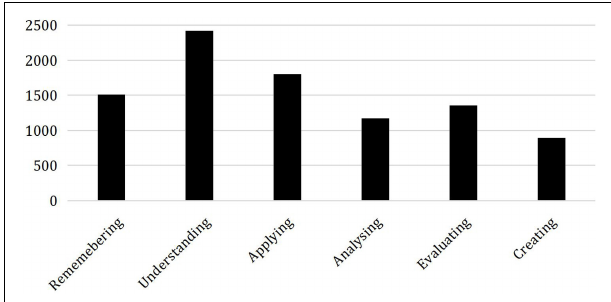
FIGURE 7 | Distribution of cognitive level.